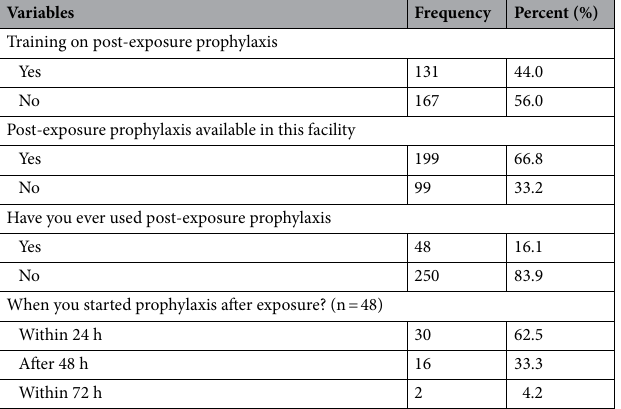
Table 3. Utilization of post-exposure prophylaxis among healthcare workers (n = 298) who had occupational exposures to HIV in St. Peter’s specialized hospital, Addis Ababa, Ethiopia, April 2022.